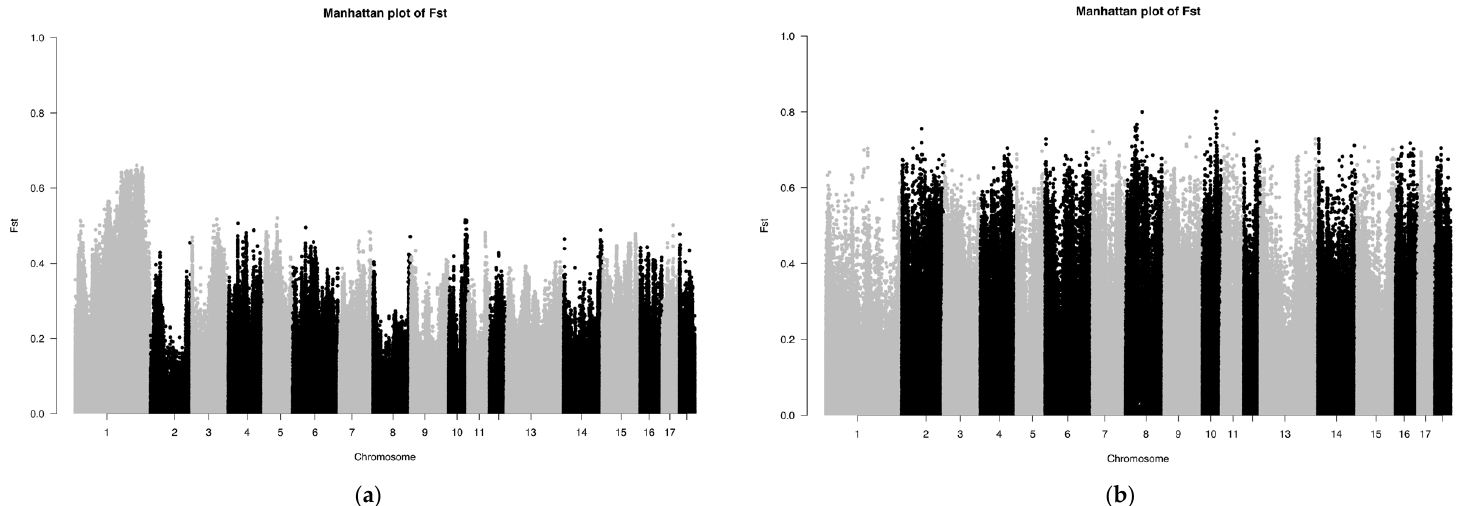
Figure 4. ( a,b ) Manhattan plot based on F st of LU–LW and LU–YY pigs by SNP chip. Figure 4. ( a , b ) Manhattan plot based on F